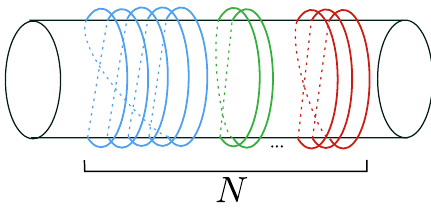
Figure 2 . The black hole microstates correspond to colored partitions of N , which can be illustrated as a collection of multiwound colored strings: N n;i is the number of strings with winding number n and color i